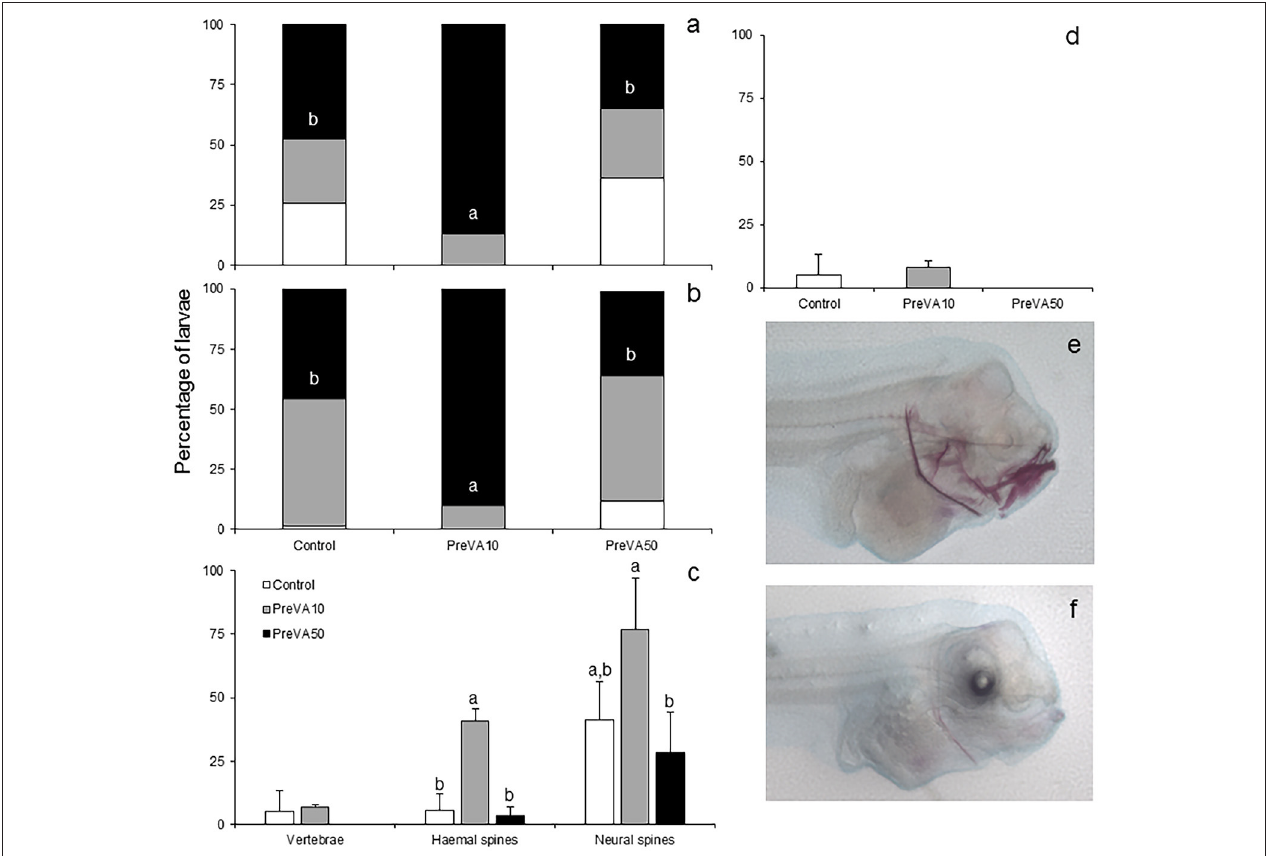
FIGURE 3 | Mineralization degree of different skeletal structures in 10 dph Senegalese sole larvae fed increased dietary vitamin A levels at different developmental stages. Percentage of larvae showing different degrees of mineralization showing fully mineralized (black bar fraction), slightly mineralized (gray bar fraction) and not mineralized (white bar fraction) structures of upper jaw (a) and lower jaw (b) . Percentage of larvae showing an onset of mineralization in axial structures (vertebrae, haemal and neural spines) (c) , and hypurals (d) . Detailed view of the degree of mineralization of several cranial structures from PreVA10 (e) and Control (f) larvae at 10 dph. Note the extended alizarin red staining in several structures (upper and lower jaws, cleithrum, ethmoid and neural spines) in the PreVA10 larvae, whereas a slight mineralization of the cleithrum in the Control larvae. For a detailed description about the different experimental groups, please see the legend of Figure 1 . Different letters within black bar fraction in graphs (a,b) or at the top of each bar on the rest of the graphs denote statistically significant differences among experimental groups (ANOVA, P < 0.05; N = 3).